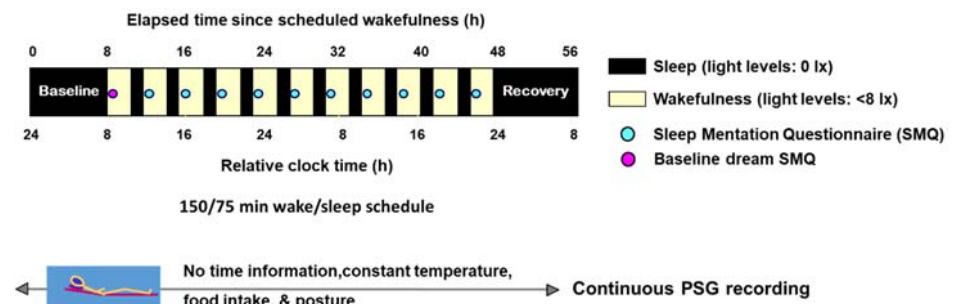
Figure 1. Schematic illustration of the 40 h multiple nap protocol. Overview of the timing of sleep and wakefulness and dream assessments in healthy controls and women with major depressive disorder (MDD) during the nap protocol (see “Study design, Section 4.2” for details). The illustration presented as relative clock time. Abbreviations: PSG: polysomnography.